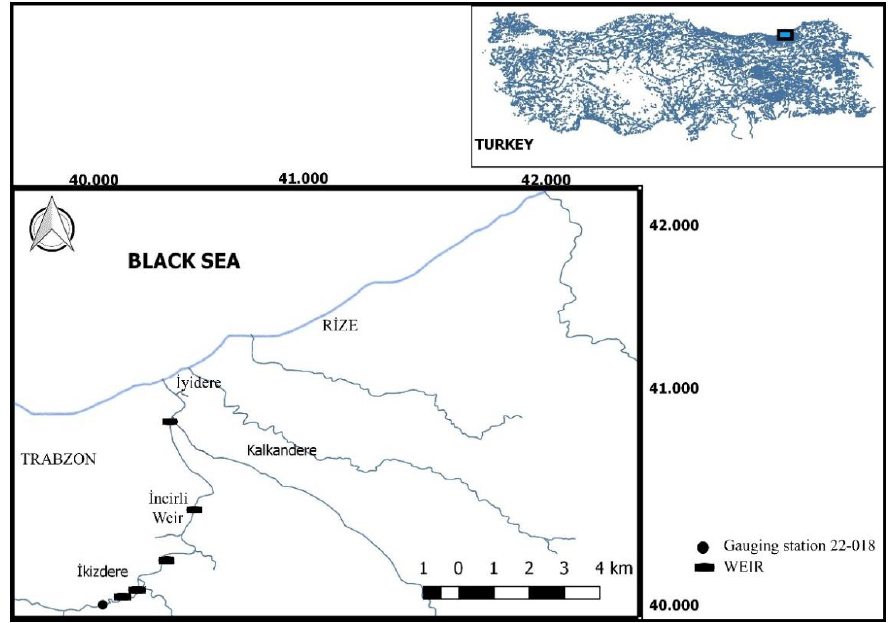
Figure 2. The location of Incirli HPP in İyidere river basin and in Turkey. Adopted from Kucukali et al. [16].